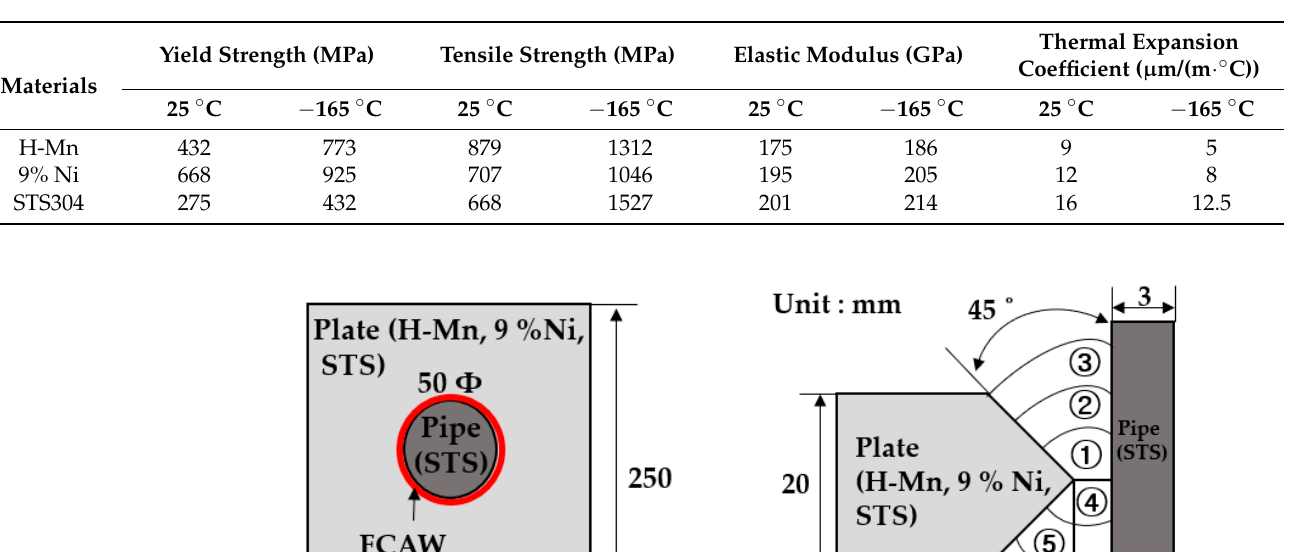
Table 2. Mechanical properties of the cryogenic steels.